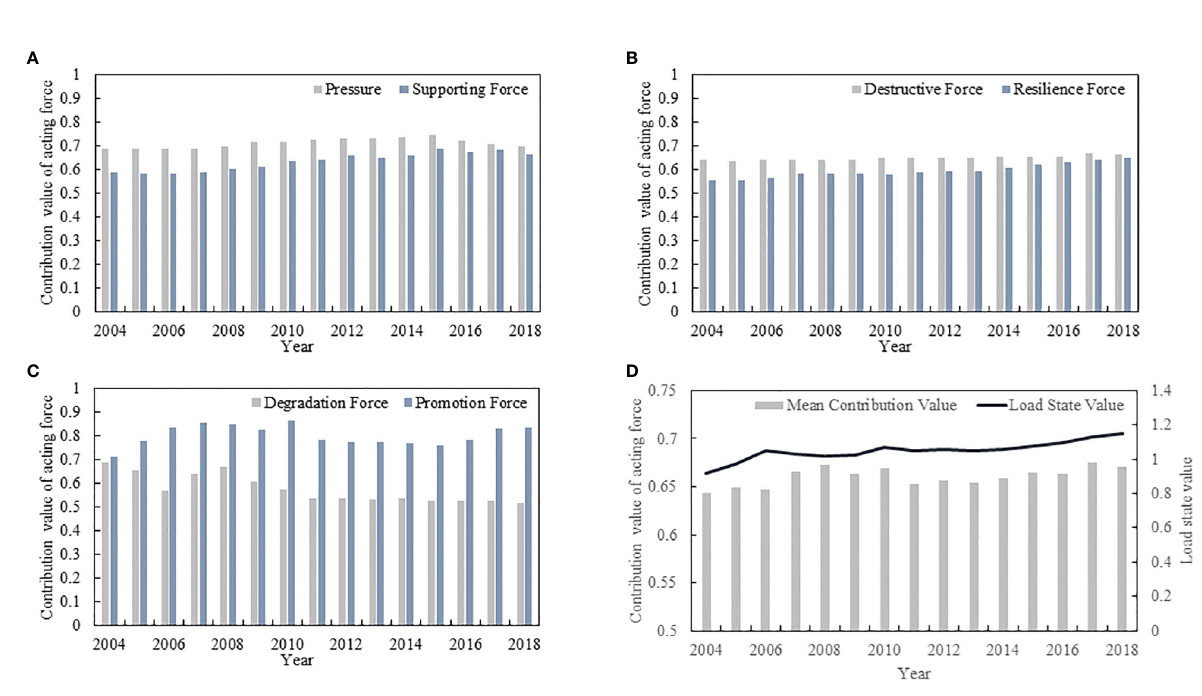
FIGURE 3 Changes of various forces and load state value in marine resource environmental carrying capacity in Zhejiang Province. (A) Pressure and supporting force changes, (B) Destructive force and resilience force changes, (C) Degradation force and promotion force changes, and (D) Mean contribution value of all component forces and load state value of marine resource environmental carrying capacity changes.